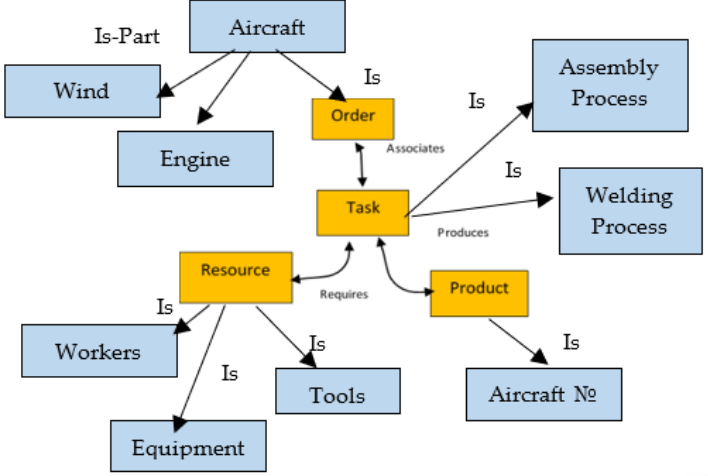
Figure 2. The basic (in yellow) and domain ontology for manufacturing (in blue).